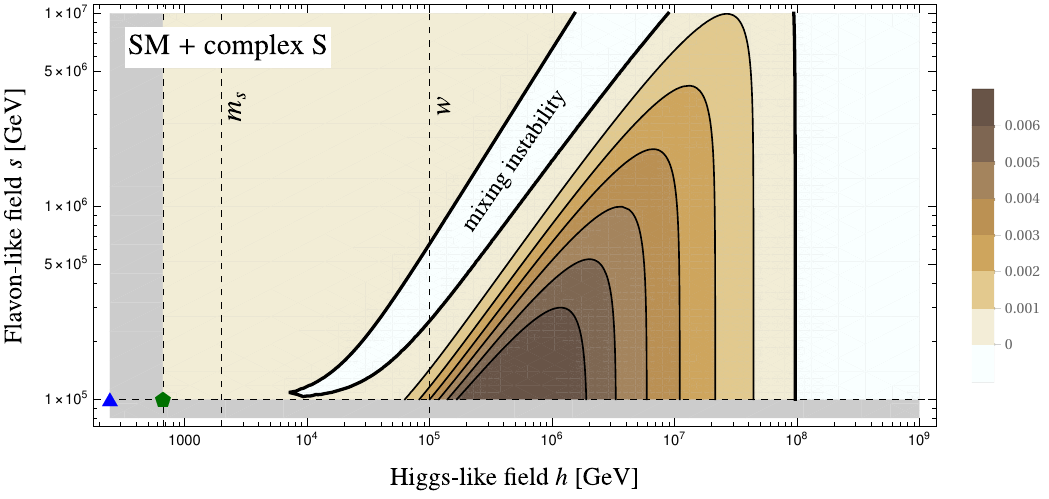
Figure 5 . EFT landscape for the SM matched to a SM+complex scalar with m 10 5 GeV and (cid:18) = 10 (cid:14) . The (cid:13)avon direction is destabilized by mixing. The vacuum stability of the SM+complex scalar in a DM context has quantitatively been discussed in [23, 24].